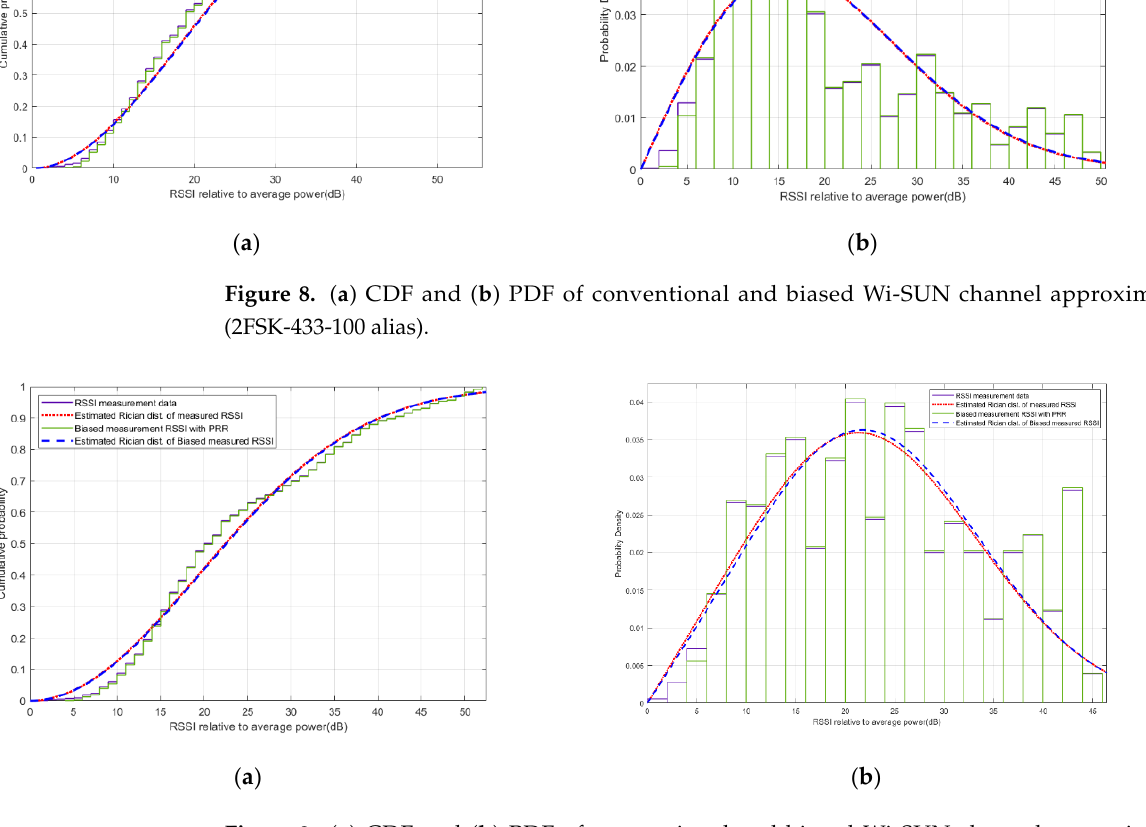
Figure 9. ( a ) CDF and ( b ) PDF of conventional and biased Wi-SUN channel approximation (2FSK-433-200 alias).